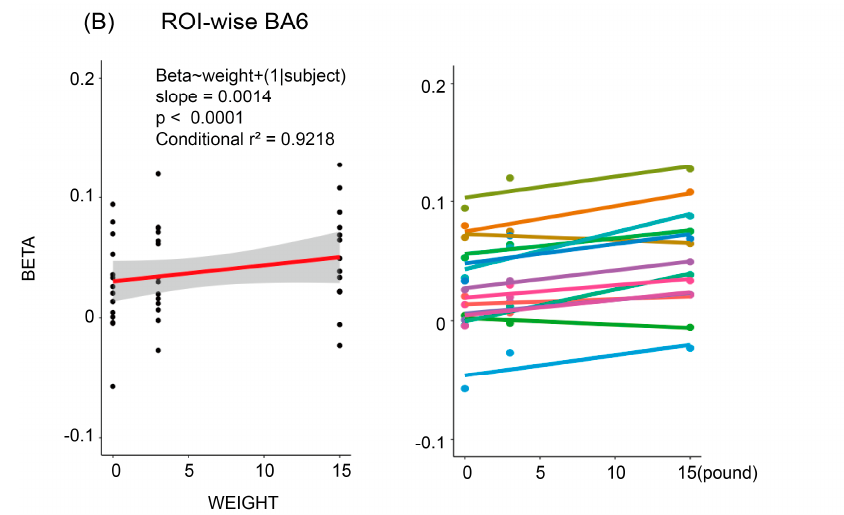
Figure 7. ROI-wise correlation between beta coefficients and weight. We plotted the sample-regression line to display the overall tendency. ( A ) Pooled and individual data in BA4. ( B ) Pooled and individual data in BA6. Effects of load on the cortical activation level (measured by the mean beta-value of ROIs) were fitted using mixed-effect linear models. The corresponding p -value and conditional r-square from mixed-effect linear models were placed above the regression line for each ROI. Significantly positive correlations were found in both ROIs.